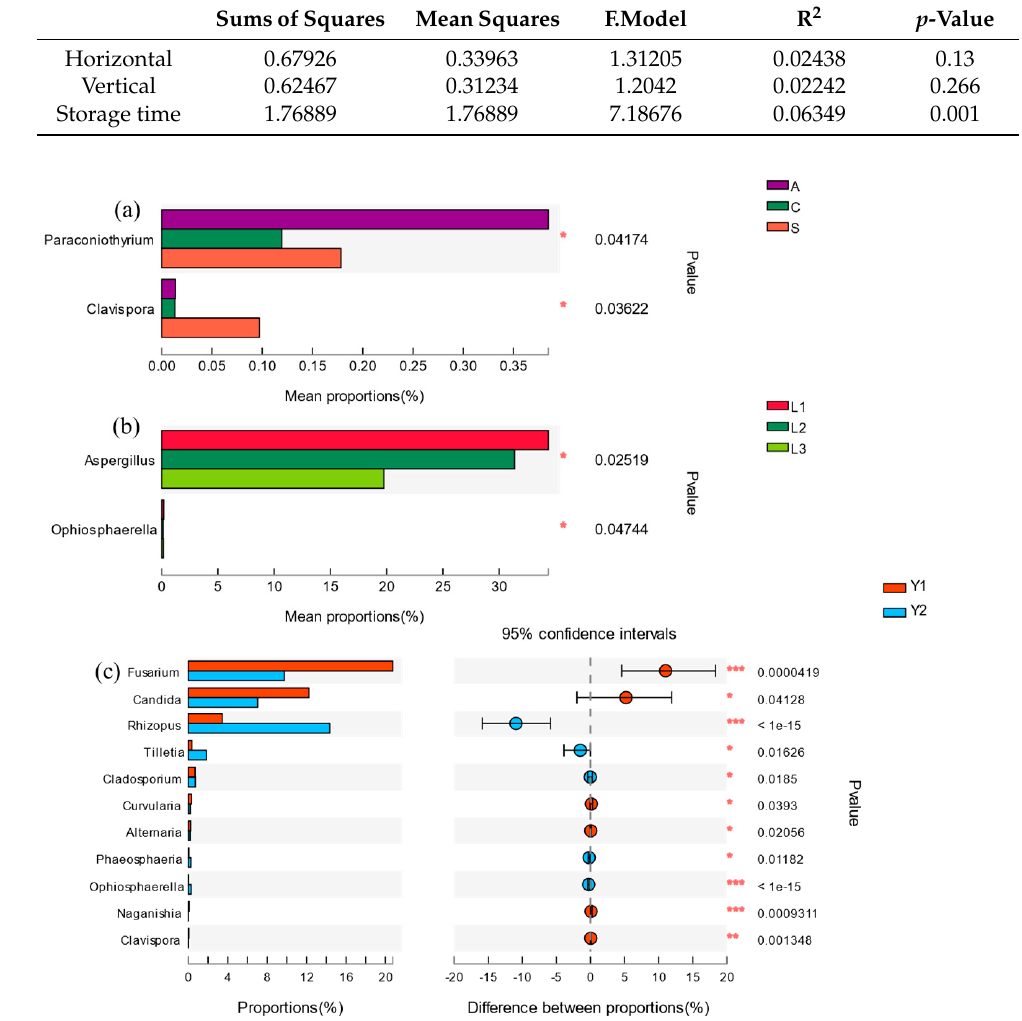
Table 3. Multivariate analysis of variance of the orientation, vertical position and storage time effect on fungi.